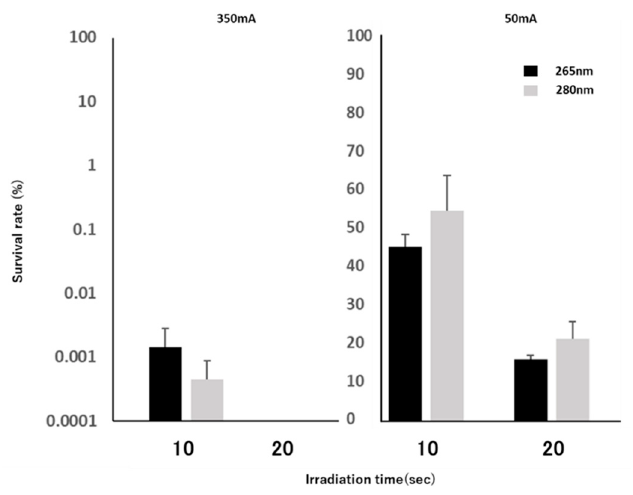
Figure 4. Quantitative test of the bactericidal effect of DUV-LED light irradiation on Fusobacterium nucleatum . The survival rates of F. nucleatum after irradiation with 265 nm LED (black bars) and 280 nm LED (grey bars) are shown for the application of 350 mA or 50 mA of current. Error bars indicate standard